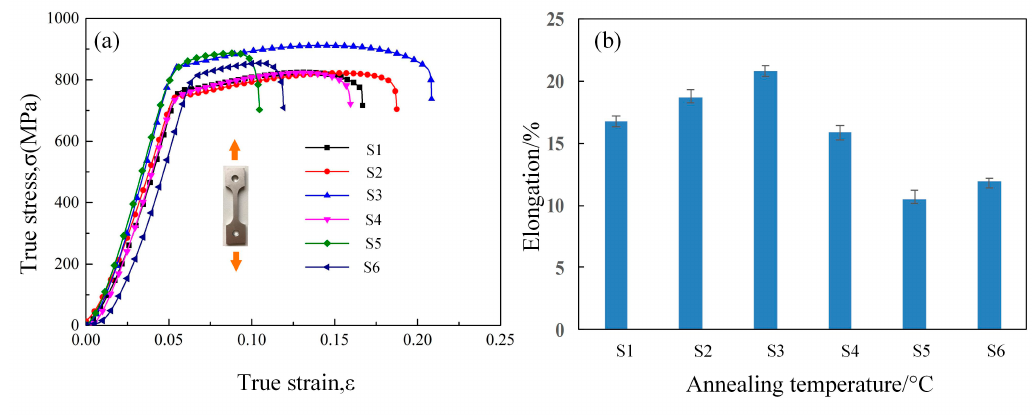
Figure 4. The tensile properties at room temperature ( a ) and elongation ( b ) with different initial microstructures.